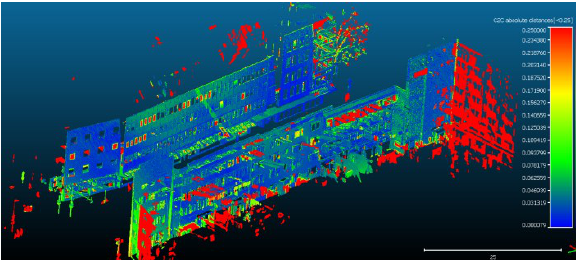
Figure 13. Distance between two LiDAR scans computed by CloudCompare (blue is 0 cm, green 10 cm and red 25 cm)